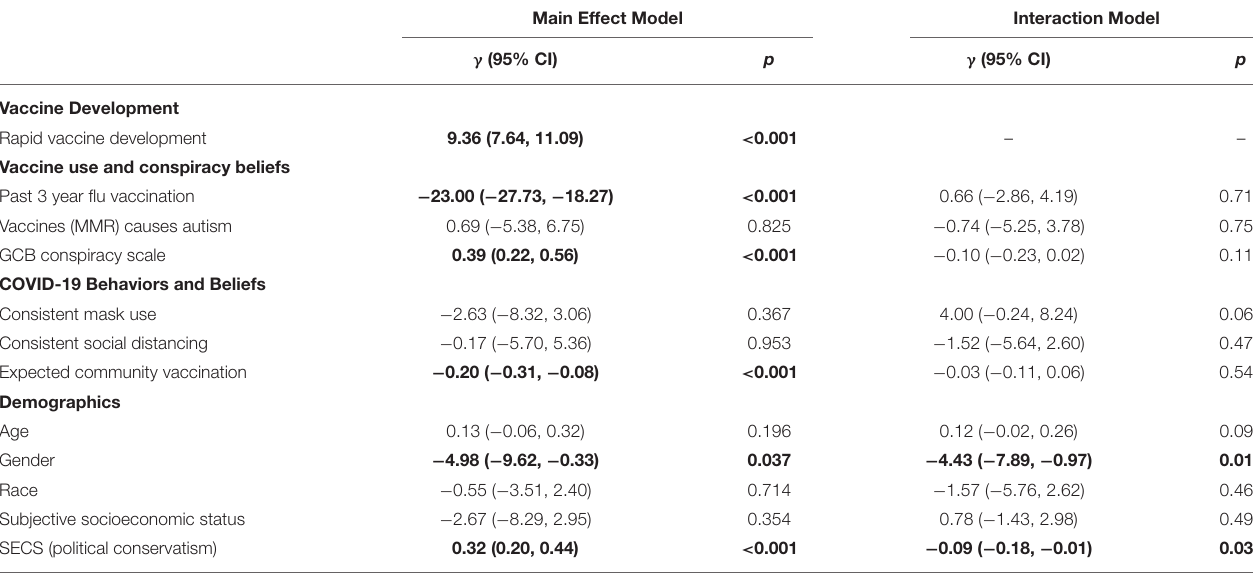
TABLE 1 | Linear mixed effect multivariable models for individual minimum required vaccine